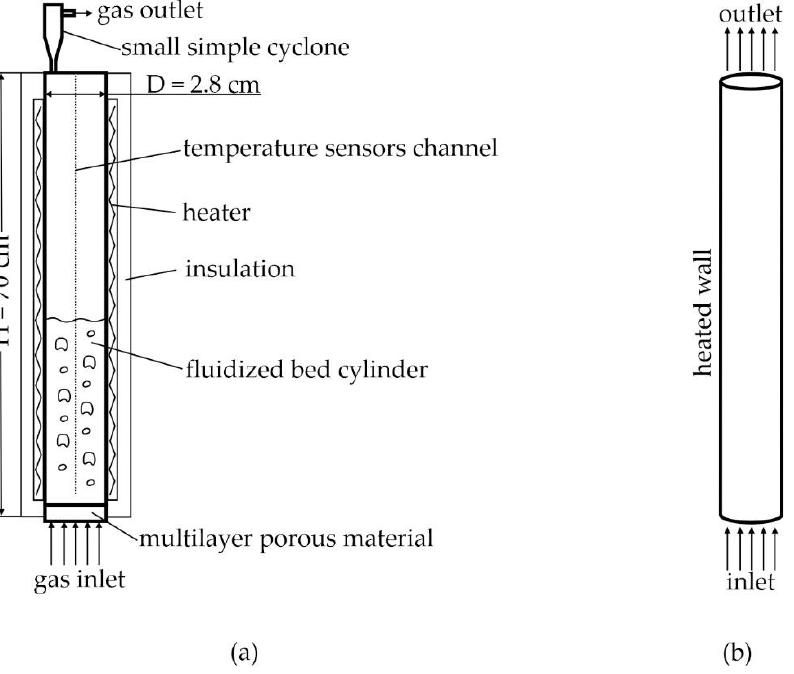
Figure 1. Laboratory reactor: ( a ) experimental reactor scheme; ( b ) 3D model of computational do-